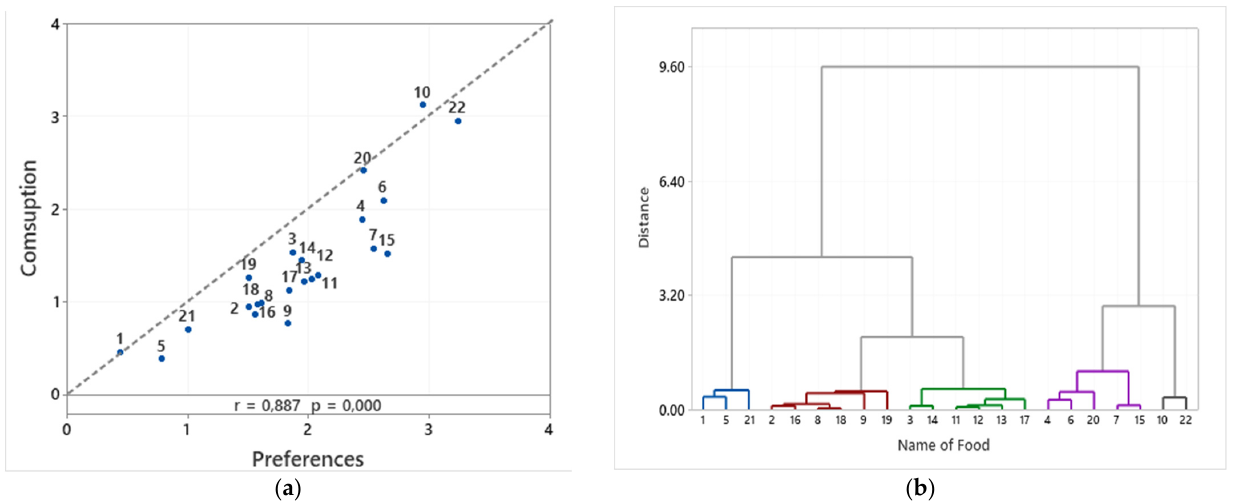
Figure 1. ( a ) Pearson correlation between consumption frequency and preferences of vitamin D-containing foods; ( b ) hierarchical cluster analysis dendrogram with four distinguished vitamin D-containing foods.